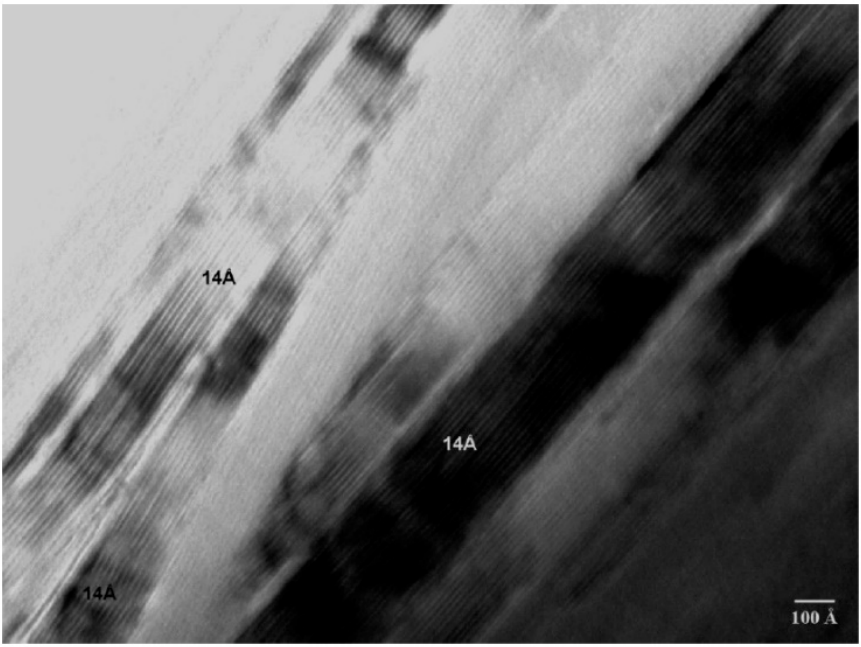
Figure 7. HRTEM image of a sample from interval R1 with subparallel small packets of neoformed chlorite with a 14 Å sequence.